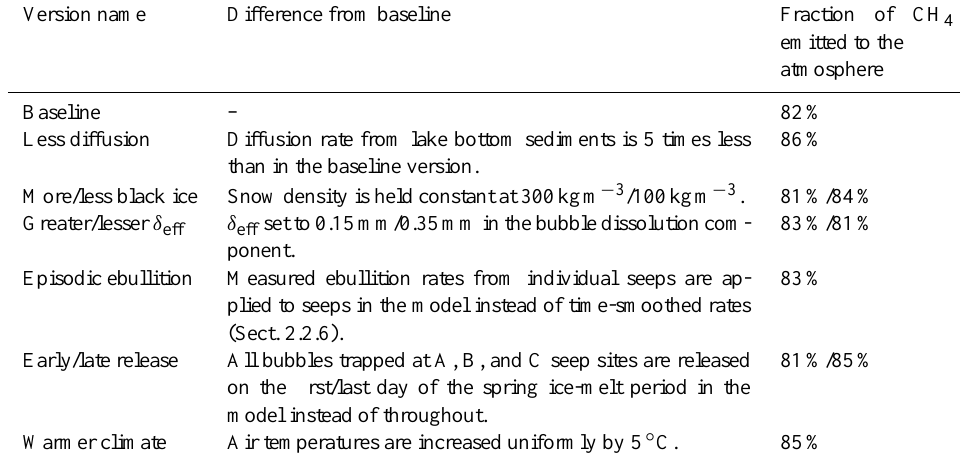
Table 1. Names of the versions of the model discussed as sensitivity analyses in Sects. 3.4 and 3.5 and Appendix A, and descriptions of how they differ from the baseline version, described in Sect. 2.3. At right, the fraction of CH 4 in each version released annually from the sediments of Goldstream Lake, either by diffusion or ebullition, that is emitted to the atmosphere without being consumed by